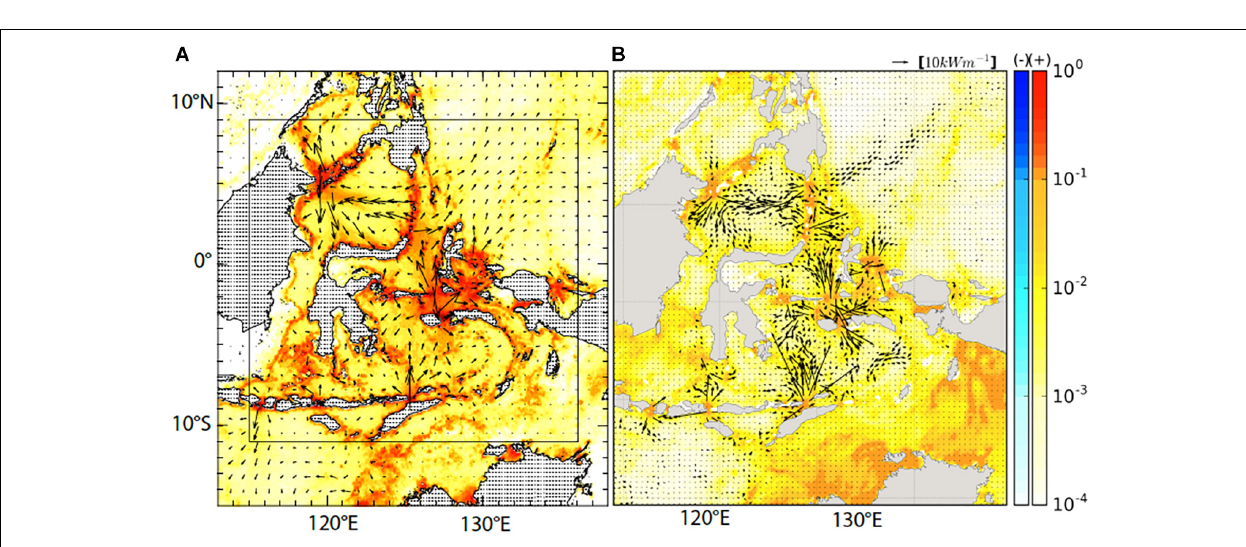
differs on time scales of interest from diurnal to